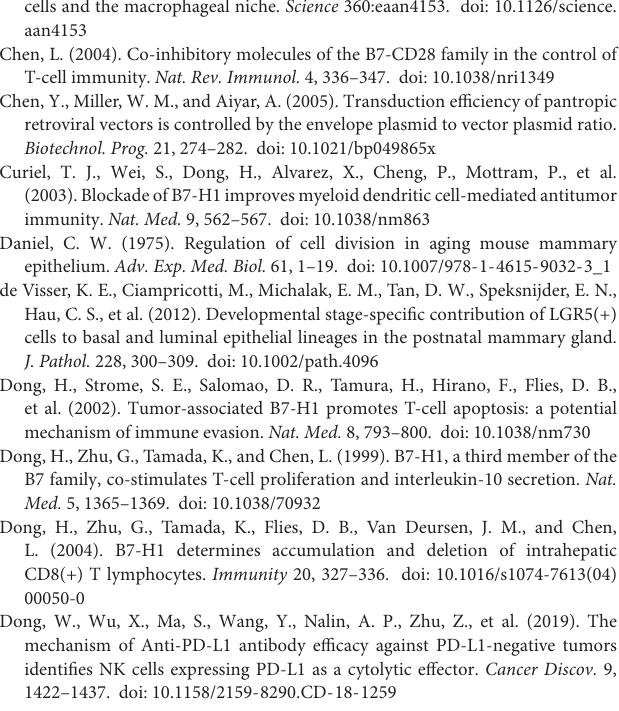
fluorescence-activated cell sorting; PD-L1, programmed cell death ligand 1. Supplementary Figure 5 | PD-L1 transcription is regulated by Wnt/ß-catenin signaling. (a–c) FACS analysis of PD-L1 expression in mammary glands of 5-, 10-, and 16-week-old wild-type mice. All mice are FVB/N genetic background. The proportion of PD-L1 + basal cells were analyzed; n = 3 mice. (d–f) FACS analysis of PD-L1 expression in mammary glands of 5-, 10-, and 16-week-old MMTV-Wnt1 transgenic mice. All mice are FVB/N genetic background. The proportion of PD-L1 + basal cells were analyzed; n = 3 mice. FACS, fluorescence-activated cell sorting; PD-L1, programmed cell death ligand 1. Supplementary Figure 6 | PD-L1 + mammary basal cells enrich EMT-related genes. (a,b) Heat map analysis showed that expression of EMT-related (b) genes was enriched in PD-L1 + basal cells. (c) qPCR analysis of EMT-related genes, which shows elevated expression in PD-L1 + basal cells compared to PD-L1 − basal cells. Data are presented as the mean ± SD. Unpaired t -test: ∗ P < 0.05; n = 3. PD-L1, programmed cell death ligand 1;